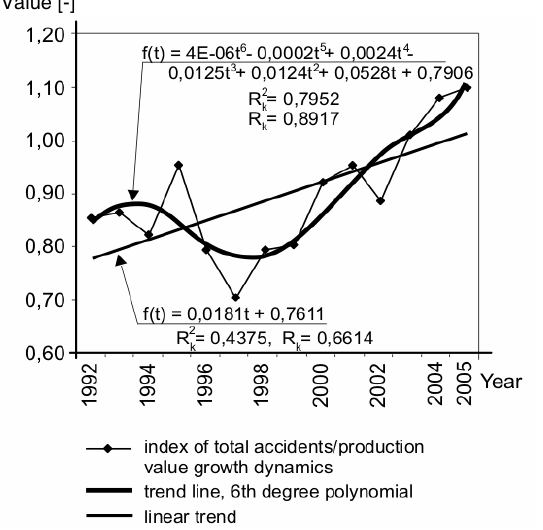
Fig 9. Total accident rate dynamics to construction pro- duction value dynamics in